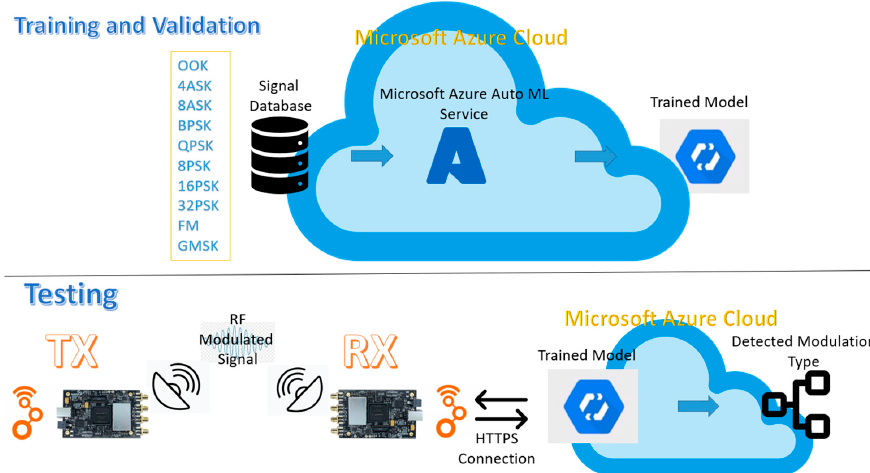
Figure 2. System functional components.